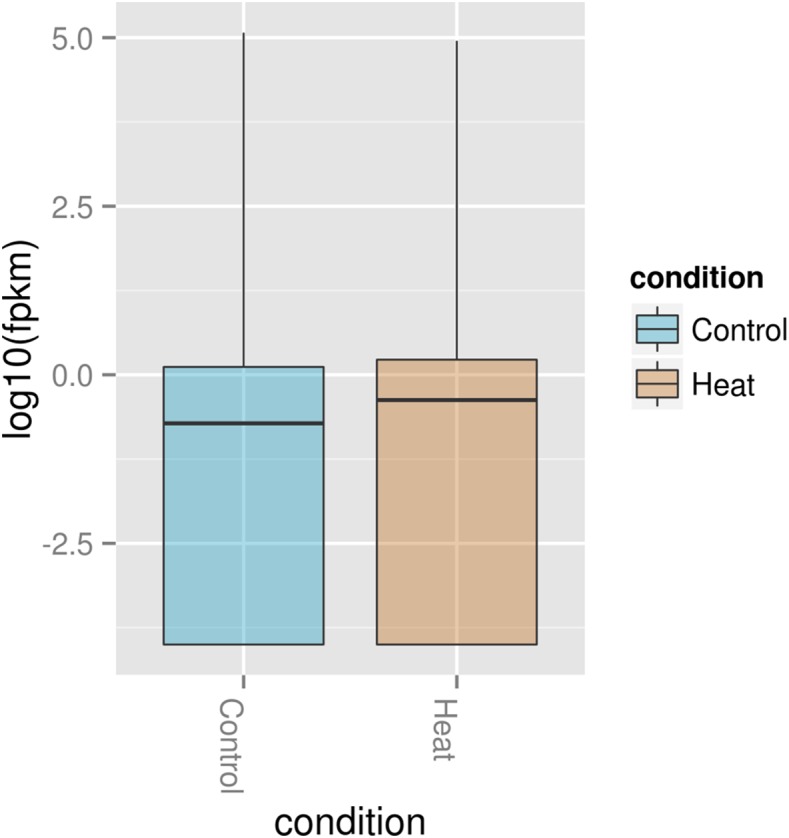
Box plot of normalized expression values of RNA in P. aeruginosa PAO1 exposed to 37 and 46 °C.The Box plot shows that how log2 transformed values of the expressed genes in P. aeruginosa PAO1 when grown at 37 °C (Control) and 46 °C (Heat). A Box plot of gene expression distribution is shown for genes falling into each bin. The bottom and top of the Box are the first and last quartiles and the line within the box is the 50th percentile [the median] of the points in the group. The Box plot median shows that expression at 37 °C (Control) is slightly lower than 46 °C (Heat).